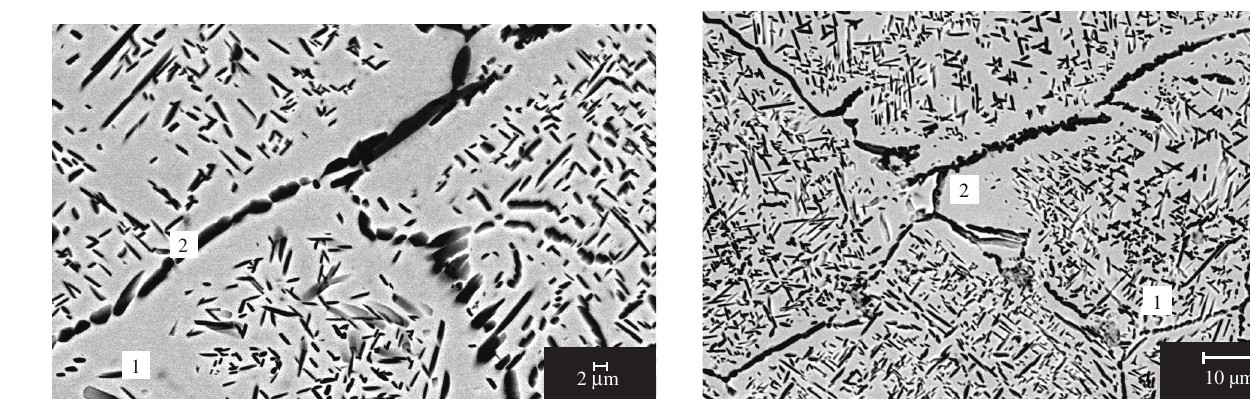
Figure 2. β -phase (1), α -phase (2) areas analyzed for EDS in Ti-35NB-